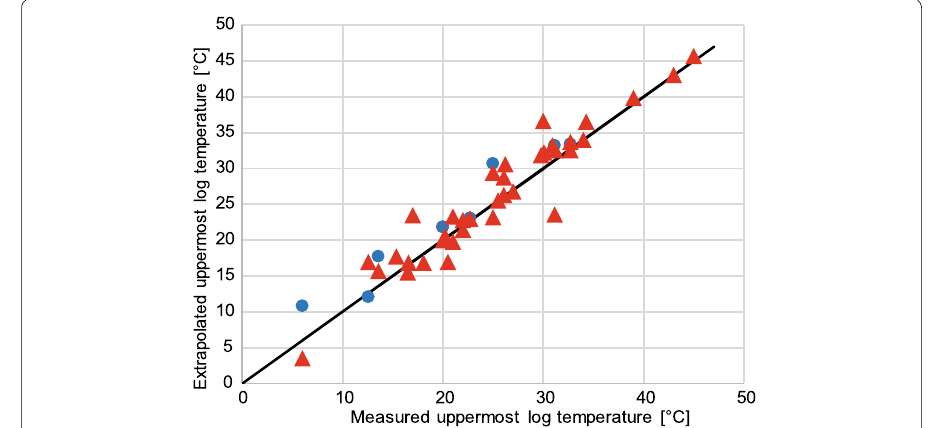
Fig. 5 Measured versus extrapolated uppermost log measurements. The black line indicates the perfect fit. Blue dots: extrapolations using values starting in a depth of 200 m; red triangles: extrapolations using values starting in a depth of 500